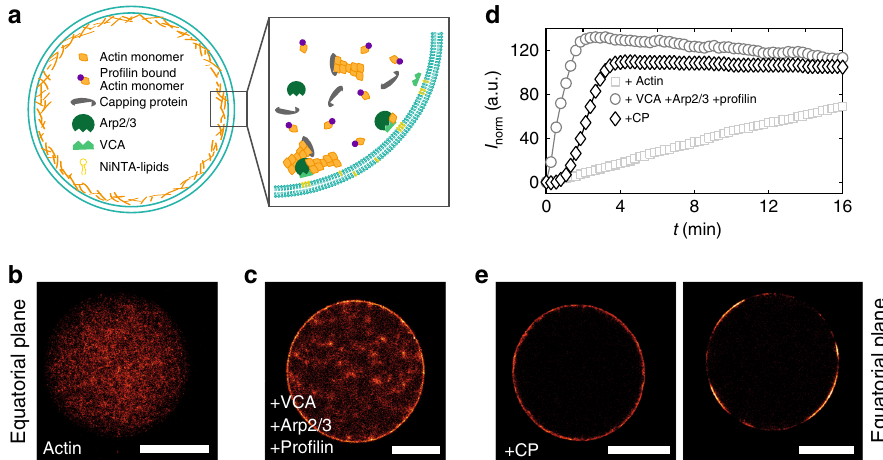
Fig. 1 Actin polymerization at the membrane is mediated by Arp2/3 complex and CP. a Molecular components required to produce cytoskeletal vesicles: Actin, His-tagged VCA, Arp2/3 complex, CP and pro fi lin were encapsulated inside of giant unilamellar vesicles (GUVs). They contained 10% Ni-NTA lipids to localize His tagged VCA to the membrane and 2.5% PEG2000 PE to avoid unspeci fi c protein-membrane interactions. b , c Confocal images of the equatorial plane of the cytoskeletal vesicles are shown. The encapsulation of only 3 µ M actin (red hot) resulted in pronounced bulk polymerization ( b ). The addition of 0.3 µ M Arp2/3, 0.3 µ M His-tagged VCA and 13.5 µ M pro fi lin to the solution prior to encapsulation induced localized actin polymerization at the membrane ( c ). d Pyrene fl uorescence assays of actin polymerization in the dependence of actin-binding proteins (ABPs): The polymerization rate of 3 µ M actin (squares) was increased upon addition of 0.3 µ M VCA, 0.3 µ M Arp2/3 complex and 13.5 µ M pro fi lin (circles). Further addition of 0.02 µ M CP (diamonds) resulted in a distinct lag phase before polymerization was initiated. e The addition of 20 nM CP to 3 µ M actin, 0.3 µ M VCA, 0.3 µ M Arp2/3 and 13.5 µ M shifted actin polymerization to the membrane. Two different binding modes occurred. Confocal images of the equatorial plane of the vesicles show both modes: fl at cortex (left side) and fl at actin domains (right side). Scale bars are 20 µ